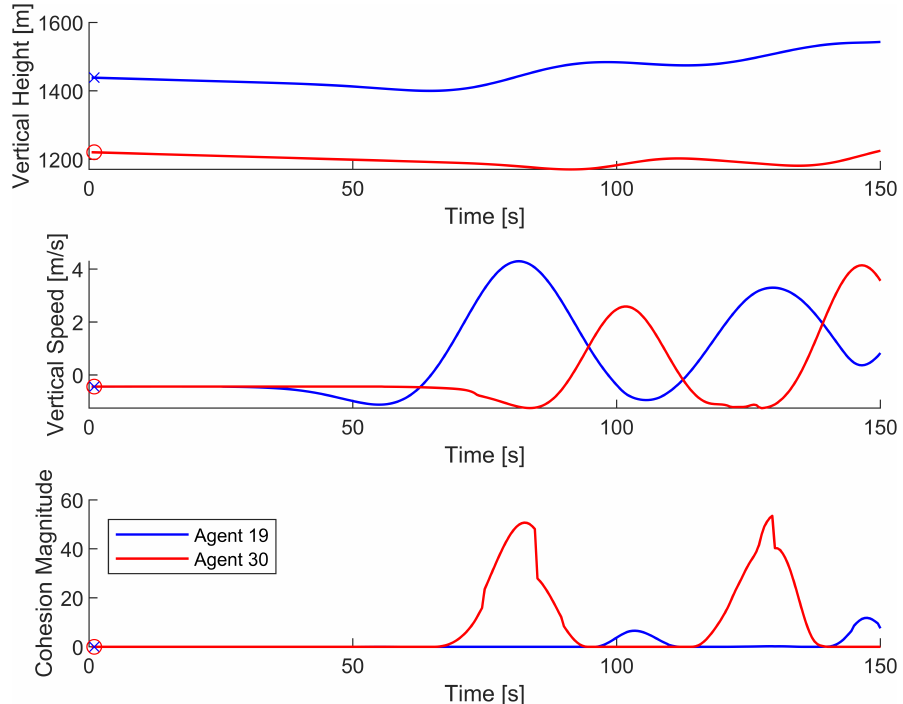
Figure 7. Vertical position, vertical speed, and cohesion magnitude data of agents 19 and 30 as they attempt to find and exploit a thermal updraft. Agent 19 is represented by the blue line and is marked with an ‘x’, while agent 30 is represented by the red line and marked with an ‘o’. The data only covers the first 150 s of the